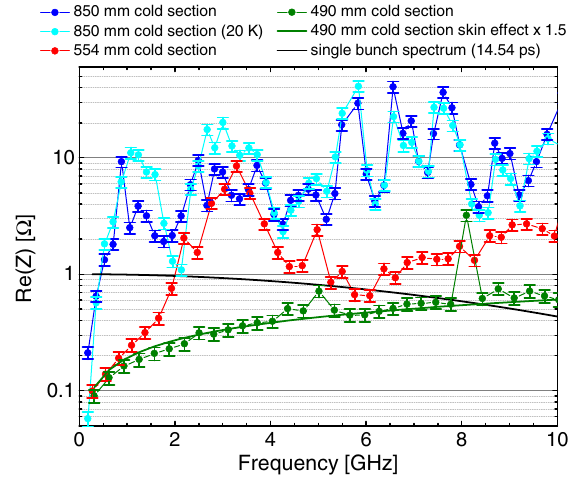
FIG. 15. Comparison between the impedance measurements on the three different sections of COLDDIAG as shown in Fig. 14 and the predicted normal skin effect for an elliptical beam pipe with the same dimensions as the 490 mm cold section, and multiplied by a factor of 1.5, which takes into account the surface roughness. The black line shows the normalized single bunch spectrum for 300 mA beam current in 900 bunches, assuming a Gaussian bunch with a bunch duration of σ ¼ 14 . 5